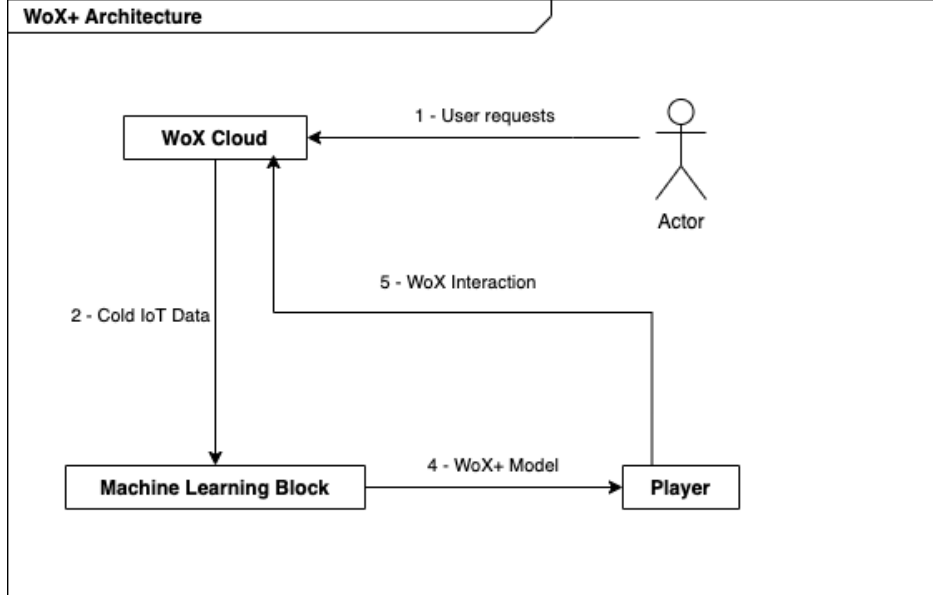
Figure 4. Solution